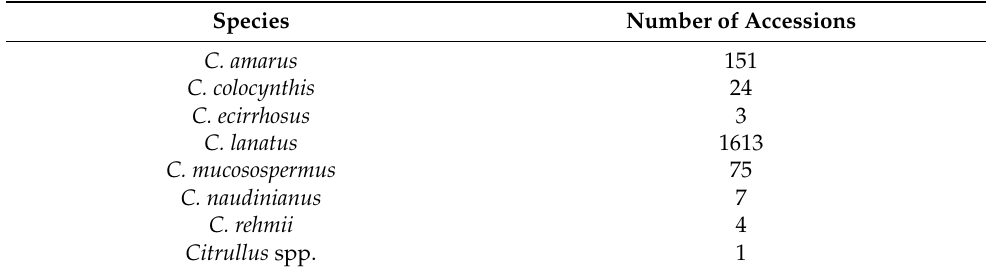
Table 3. Active Citrullus accessions in the NPGC. (https://npgsweb.ars-grin.gov/gringlobal/search. aspx) (Accessed 8 March 2021) [24].